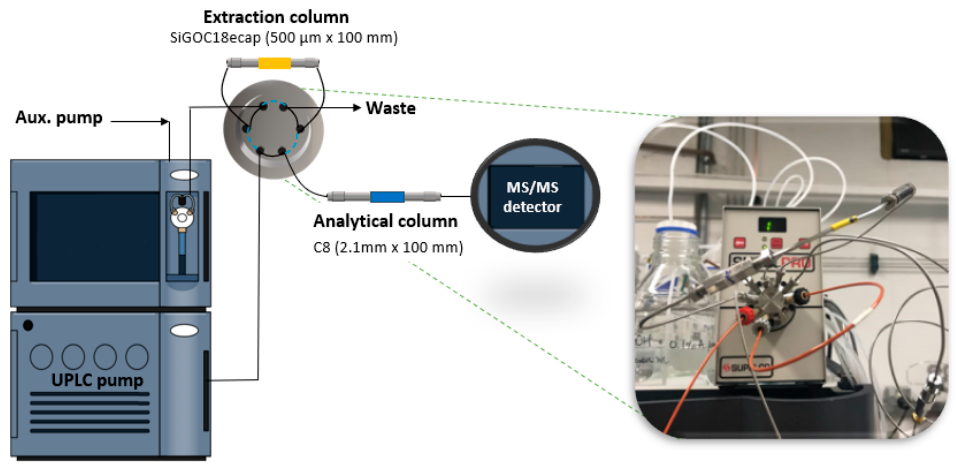
Figure 6. Representative scheme of setup 1, obtained by a coupling of the extraction microcolumn to a UPLC–MS/MS system, in flow-through mode. A six-port valve is shown in the loading (black trace) and elution (blue trace, back-flush mode) positions. In the inset, a photograph depicts the valve system.